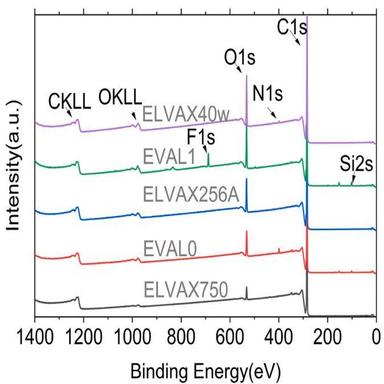
XPS survey spectra of reference EVA grades with differing VA content ordered by increasing oxygen concentration.